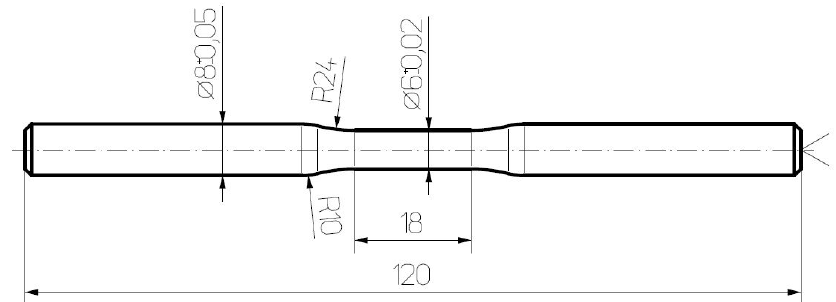
Figure 2. Specimen geometry employed for tensile and fatigue tests, units in